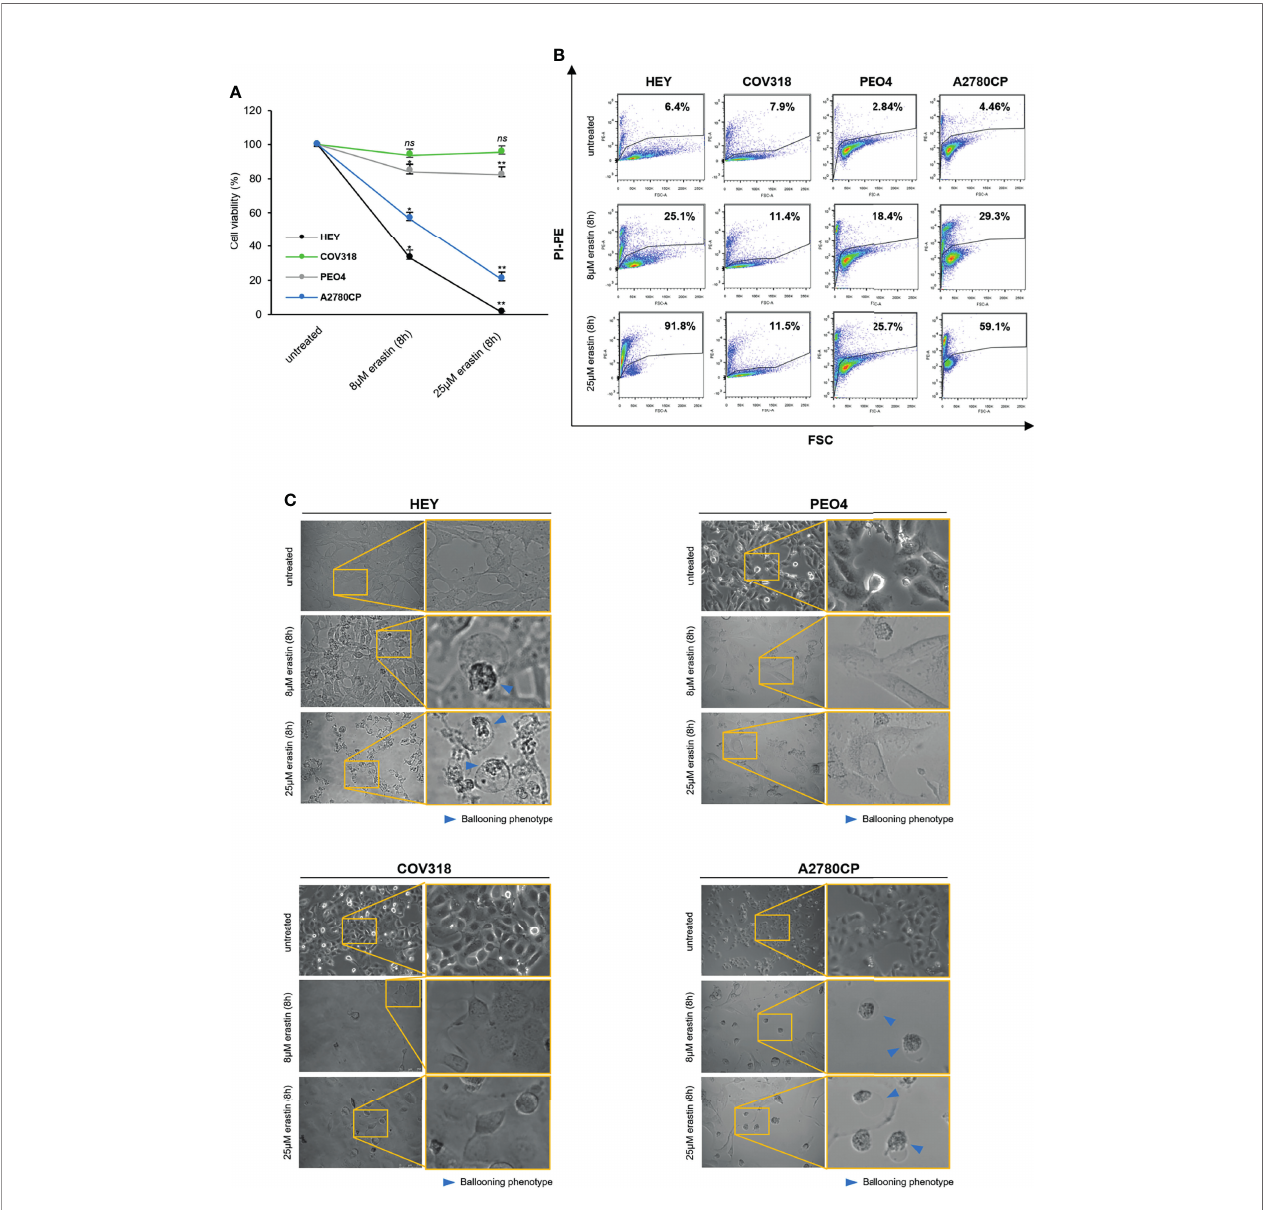
FIGURE 1 | Erastin induces ferroptosis only in a subset of OVCA cells. HEY, COV318, PEO4, and A2780CP OVCA cells were treated with different concentrations (8 and 25 µM) of erastin for 8 h. Cell viability and mortality were measured using the MTT assay (A) and the PI fl ow cytometric analysis (B) , respectively. Results are shown as means±SD of three independent experiments. * p -value <0.05, untreated vs 8 µM erastin (8 h); ** p -value <0.05, untreated vs 25 µM erastin (8 h); ns: not signi fi cant. (C) Optical microscopy images showing the presence or absence of the ballooning phenotype upon treatment with erastin (8 and 25 µM for 8